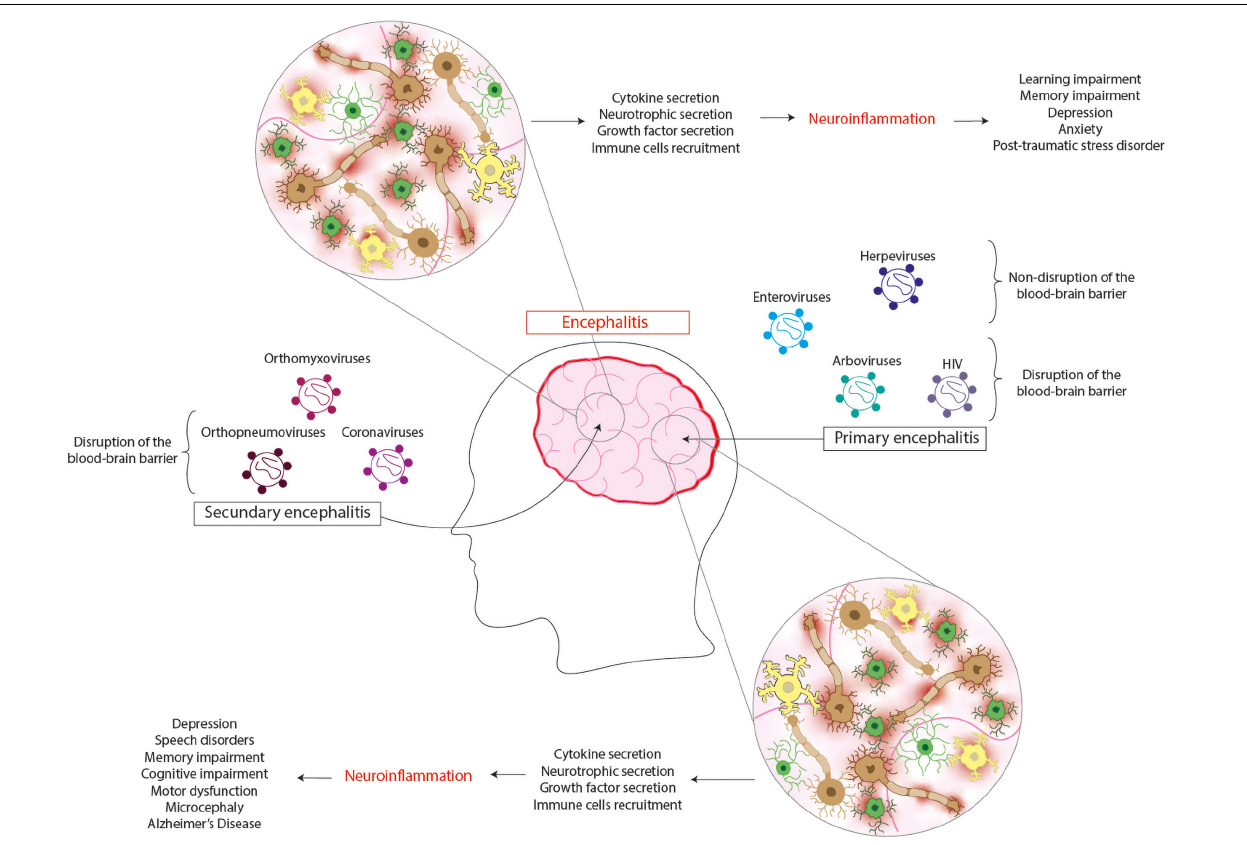
FIGURE 2 | Viral encephalitis leads to several neurologic sequelae. Primary encephalitis is caused by viruses that infect the brain as their principal target, which can be found in arboviruses, enteroviruses, herpesviruses, and HIV. The infection of cells from the central nervous system induces the cytokine, neurotrophic, and growth factor secretion and the recruitment of immune cells. It is thought that this response can contribute to neuroinflammation, leading to neurologic sequelae such as depression, speech disorders, memory, and cognitive impairment, motor dysfunction, microcephaly, and even Alzheimer’s disease. Secondary encephalitis is caused by viruses that do not infect the brain as their principal target, which can be found in orthomyxovirus, orthopneumoviruses, and coronaviruses. The infection of cells from the central nervous system induces the cytokine, neurotrophic, and growth factor secretion and the recruitment of the immune cells. This response contributes to neuroinflammation, leading to neurologic sequelae such as learning and memory impairment, depression, anxiety, and post-traumatic stress